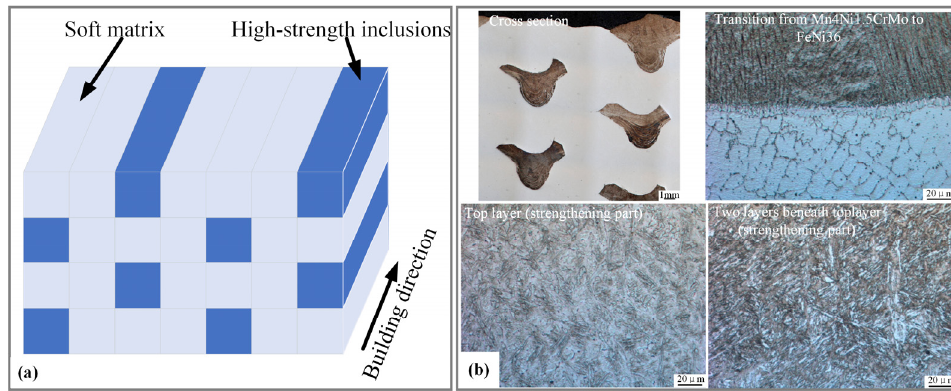
Figure 24. ( a ) Schematic for the distribution of layers, ( b ) Cross section and microstructure of layer structure [93].